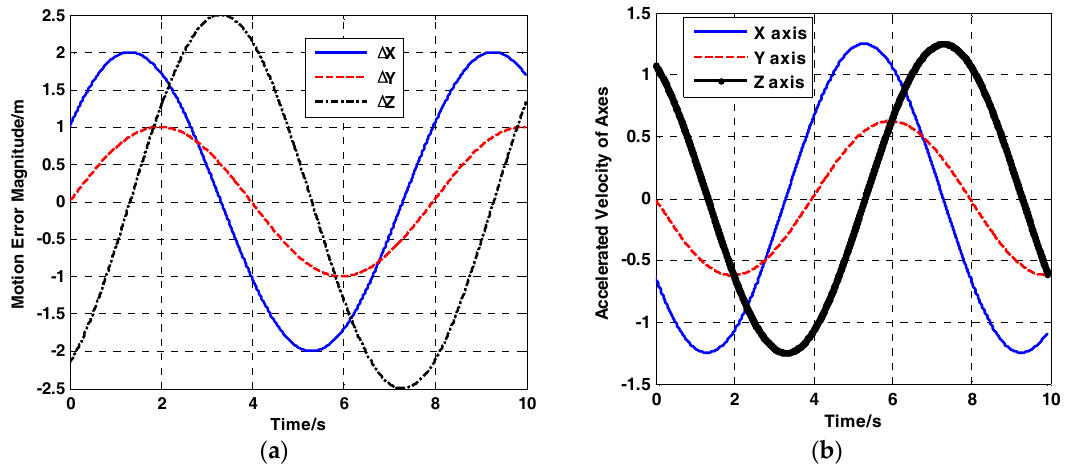
Figure 8. ( a ) Error of mild accelerated motion. ( b ) INS output.